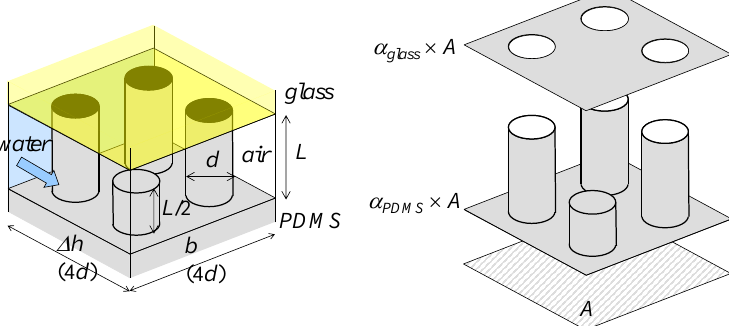
.  is the ratio between the exposed surface area of PDMS or glass f